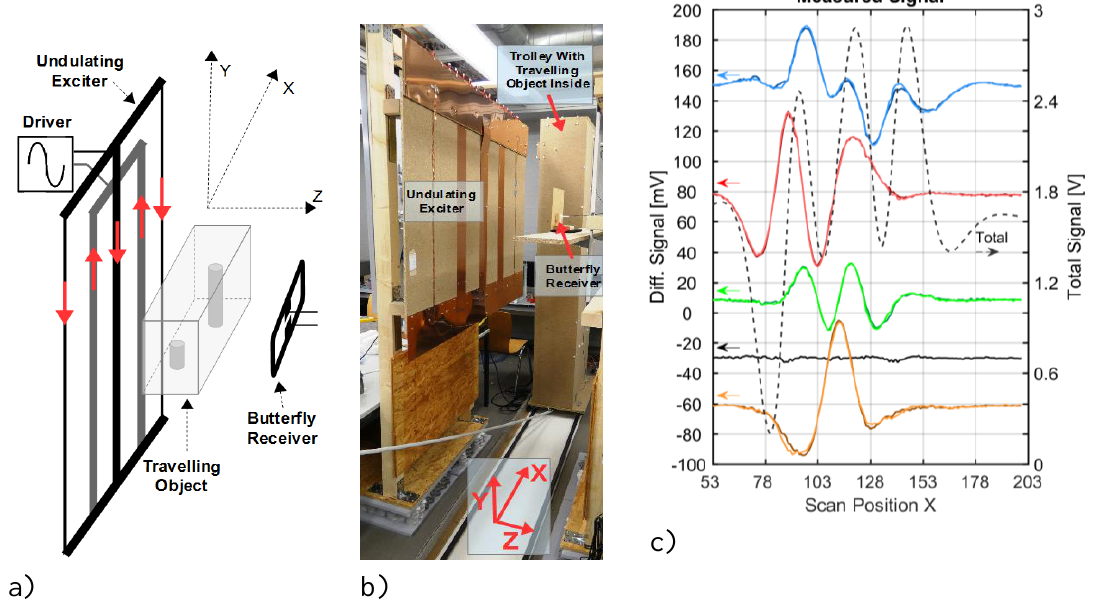
Figure 13. Scanner equipped with an undulating exciter and a gradiometric butterfly receiver. ( a ) Schematic illustration; ( b ) practical realization; ( c ) measured signals from the saline body with a non-conducting sphere (c.f. Figure 2b) at the same positions, as shown in Figure 2c. The dotted black line depicts the total signal of the cuboids; the red lines are the differential signals of the sphere when face-centered at the side wall; the blue and yellowish lines stand for the signature of the sphere towards the exciter and receiver coils (face-centered). The green lines from the center of the volume provide information clearly above the noise floor (black line).